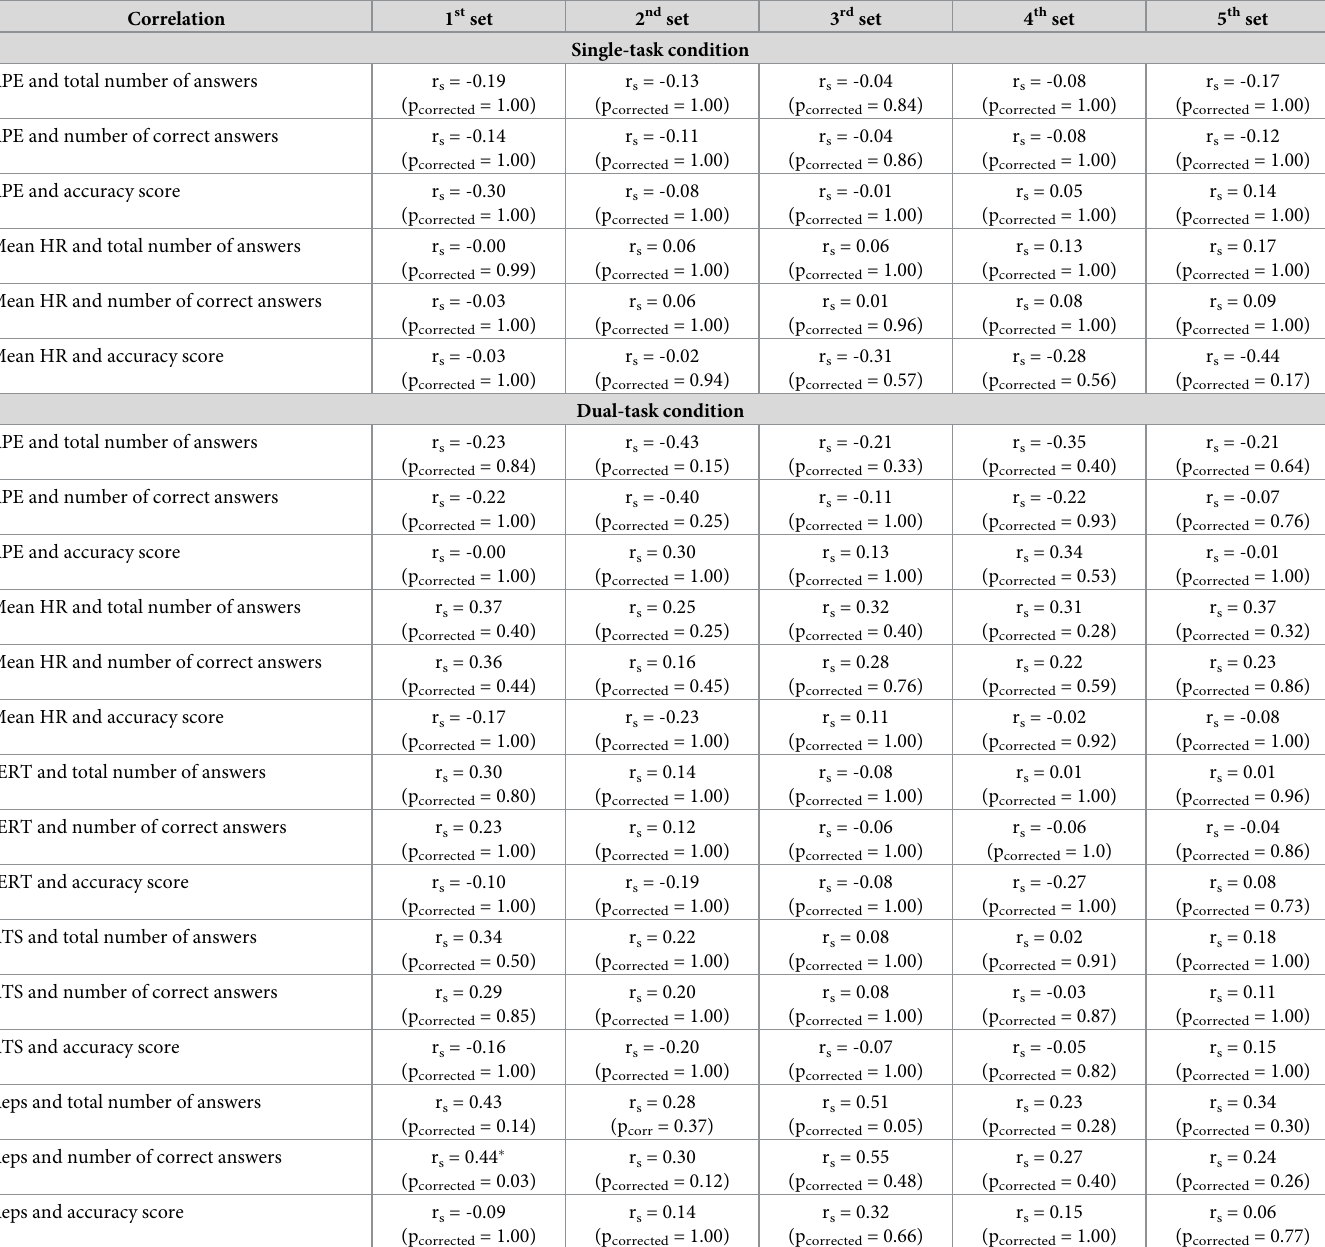
Table 3. Overview of correlation coefficients (Spearman’s Rho [r s ]) and corresponding p-values / RPE: Rating of relative perceived exertion; sERT: Self-rated expe- rience in strength training; Reps: Number of squat repetitions; RTS: Resistance training sessions per